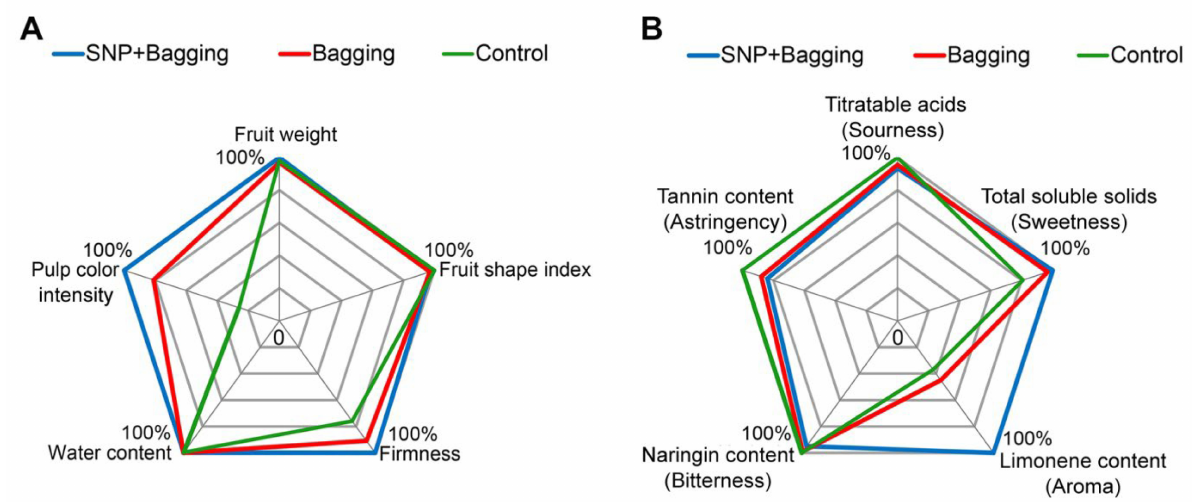
Figure 2. Effects of different treatments on the physical properties (single fruit weight, fruit shape index (size), firmness, water content, and pulp color) ( A ), aroma, and flavor compounds (titratable acids (sourness), total soluble solids (sweetness), limonene content (aroma), naringin content (bitter- ness), and tannin content (astringency)) ( B ). Relative value = measured value/max value × 100%. All measured values are shown in Table